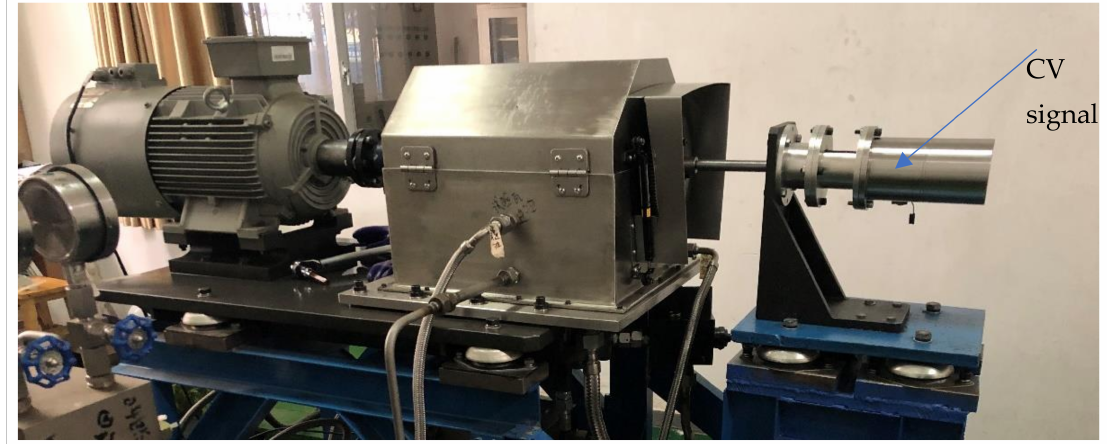
Figure 2. The fatigue test